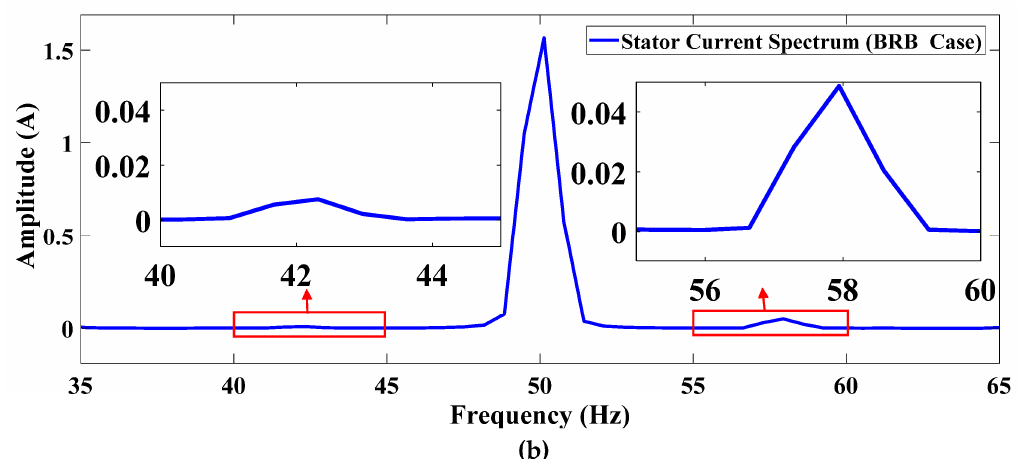
Figure 14. Stator current spectrum: ( a ) Healthy case; ( b ) BRB fault case.